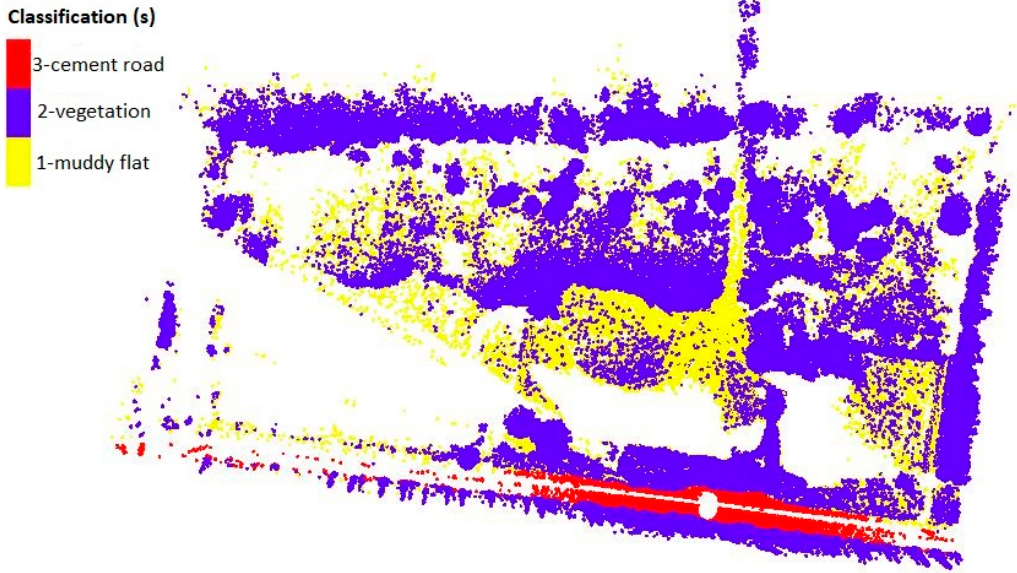
Figure 9. Combination of manual and commercial software classification (“Classify Ground Points” algorithm which use the geometrical information of the point cloud in LiDAR360).